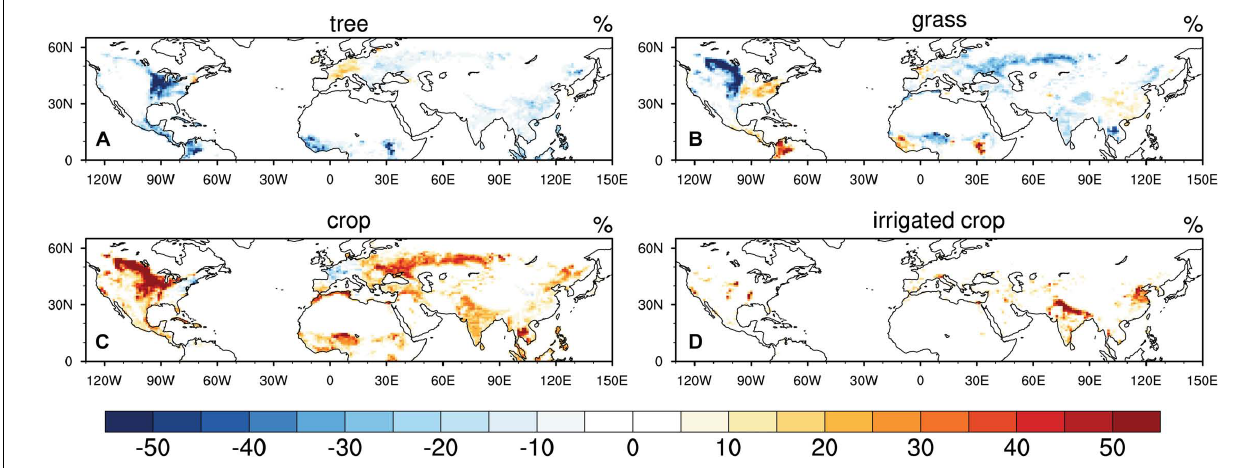
FIGURE 1 | Changes (% of each grid cell) in major plant functional types [PFTs: (A) tree, (B) grass, (C) crop] from pre-industrial to present day in the Northern Hemisphere, and areas (% of each grid cell) of the irrigated crop (D) .